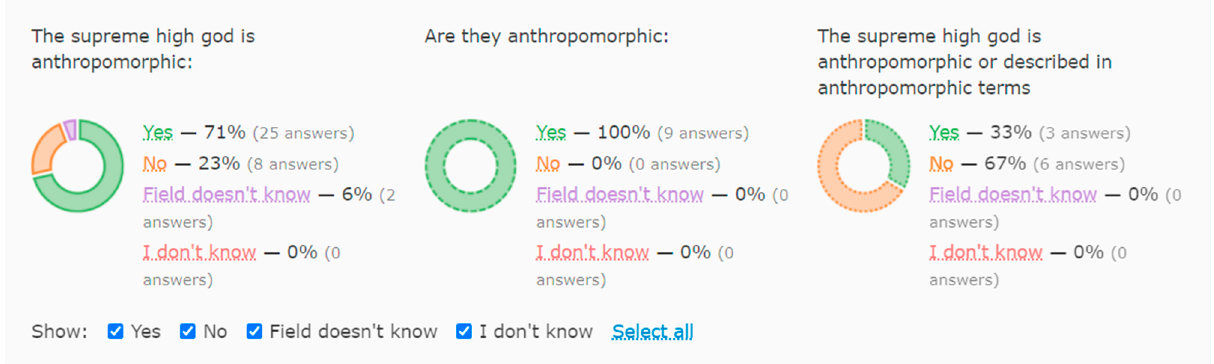
Figure 7. DRH visualization of the query “ The supreme high god is anthropomorphic ?” from 395–1204 CE focusing on the broader Mediterranean and Near East regions. The pie charts represent the “Group”, “Place”, and “Text” polls, ordered from left to right.